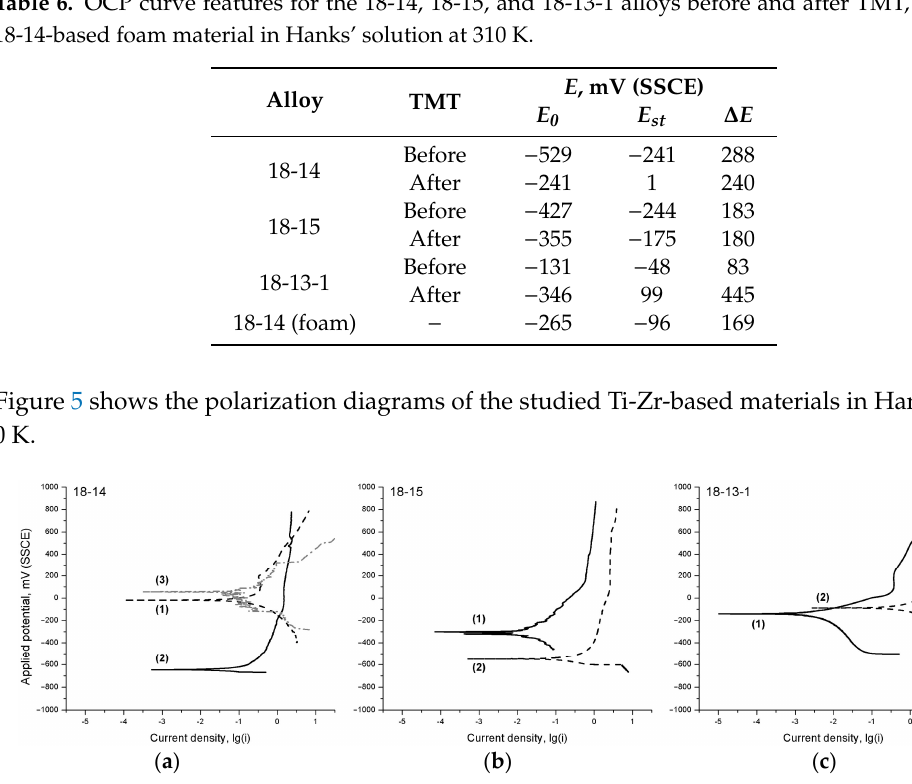
Figure 5. Polarization diagrams of ( a ) 18-14, ( b ) 18-15, and ( c ) 18-13-1 alloys (1) before and (2) after TMT, and (3) the 18-14-based foam material in Hanks’ solution at 310